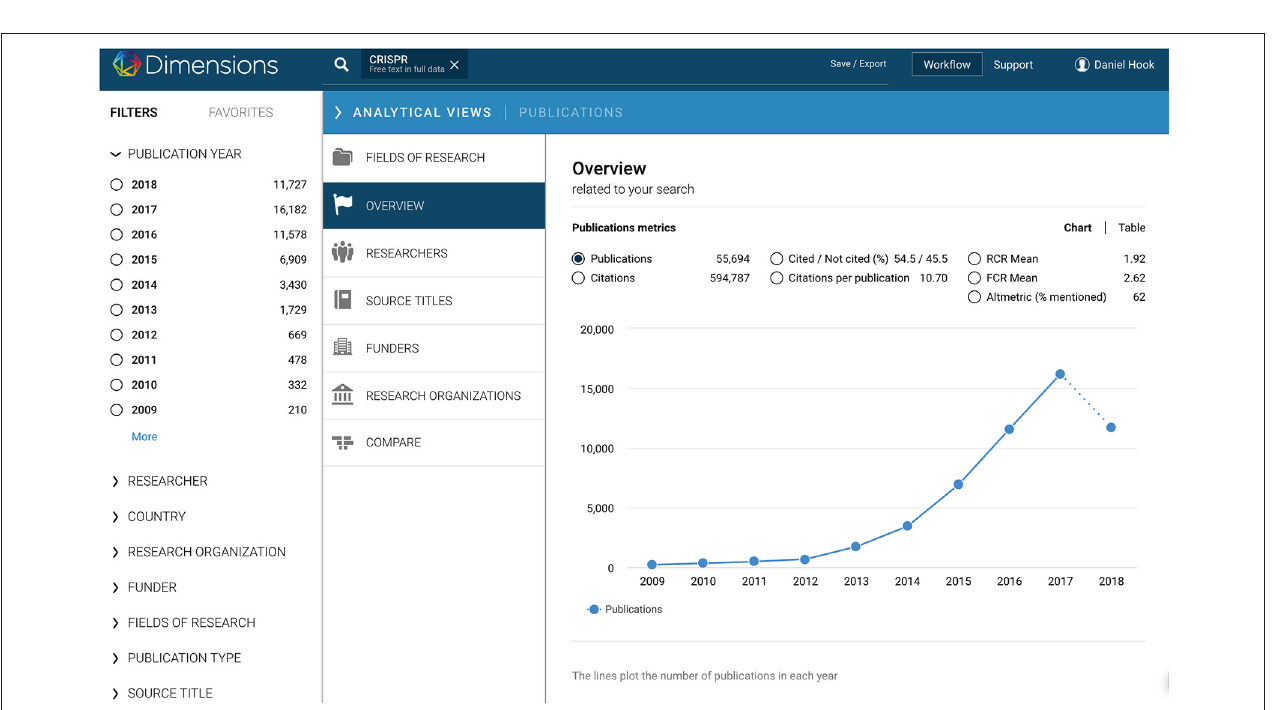
FIGURE 3 | Free (left) and paid (right) versions of Dimensions side-by-side. On the left you notice more limited filters than on the right and only the publications index is searchable. On the right, the grants, patents and clinical trials searches are visible. Not shown, a greater degree of sophistication is available in the analytics panel in the paid